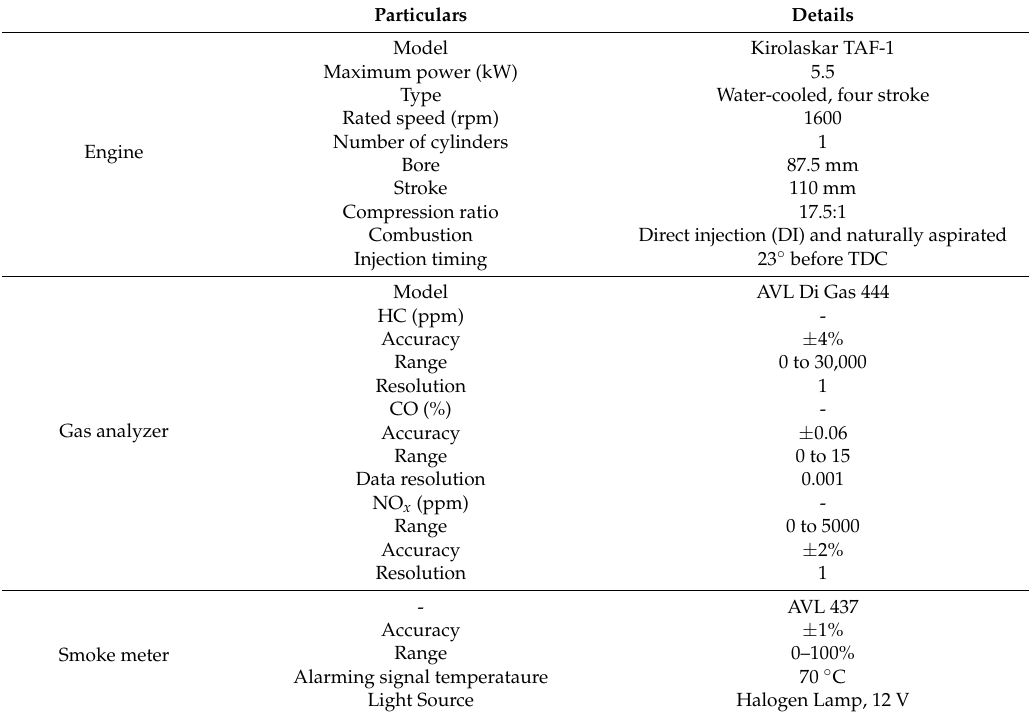
Table 3. Technical specifications of the engine used in the present